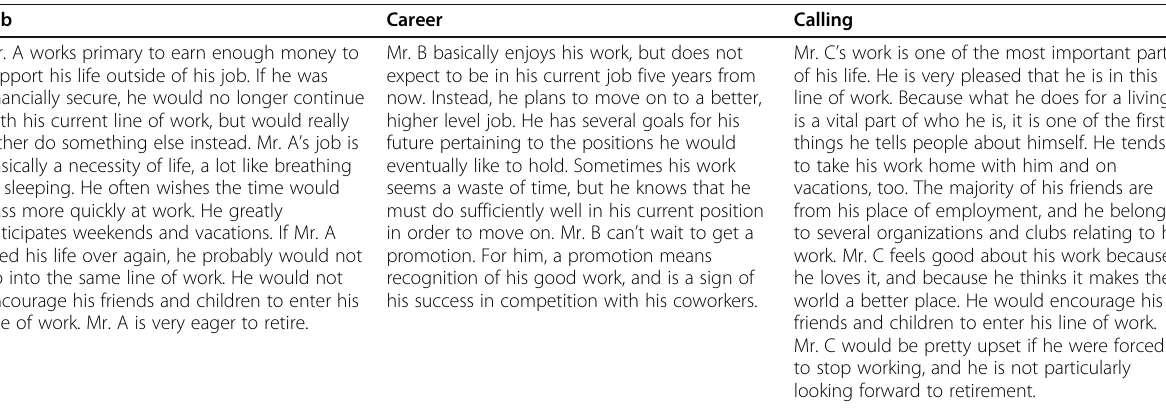
Table 2 Scenarios used to measure the relationship to work Job Career